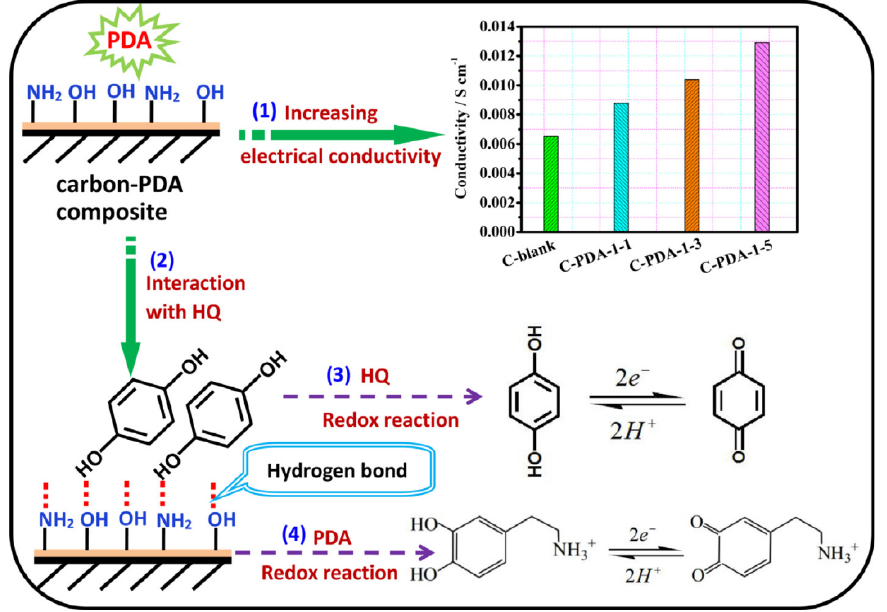
Figure 12. Schematic illustration of the carbon-PDA composite: ( 1 ) increasing electrical conductivity; ( 2 ) interaction with HQ; ( 3 ) redox reaction of HQ; ( 4 ) redox reaction of PDA. Reprinted from [91]. Copyright (2020), with permission from Elsevier.